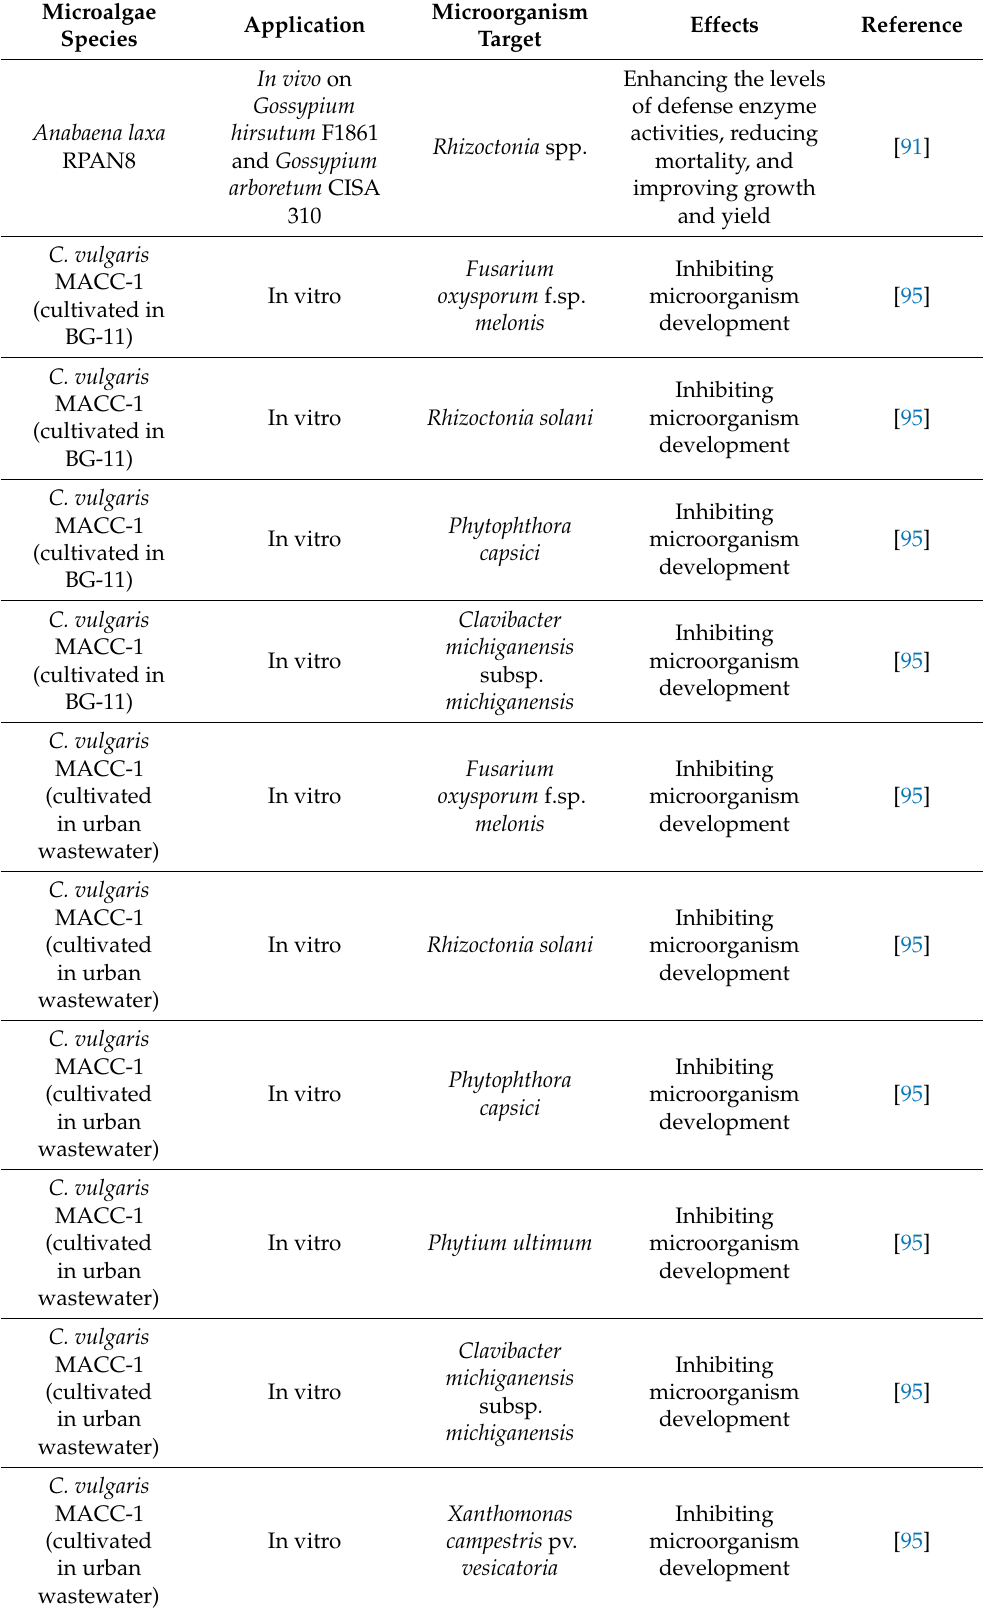
Table 5. Biopesticide effects of different microalgae